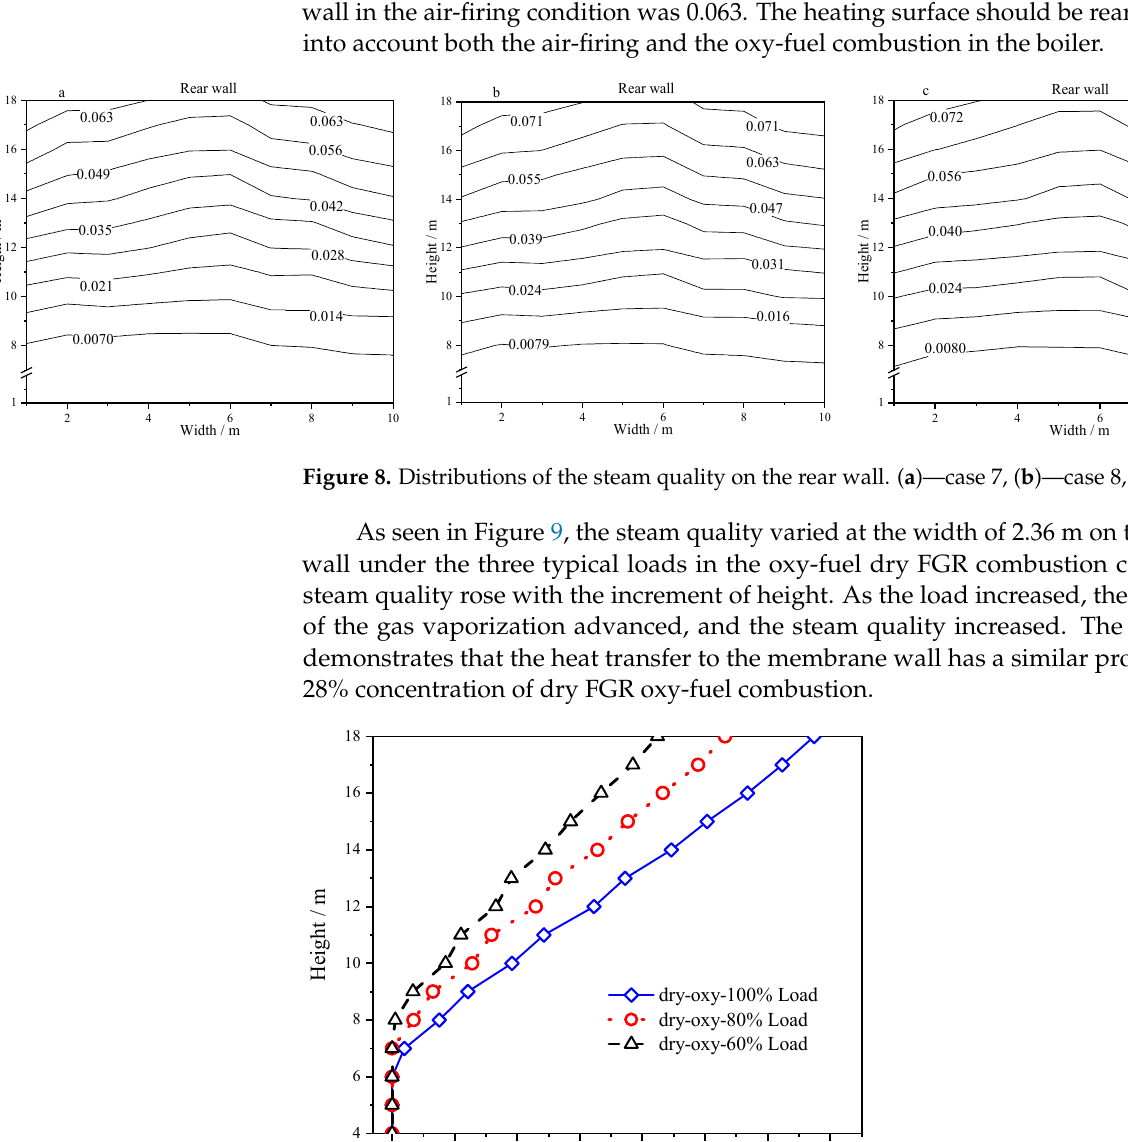
Figure 9. Steam quality on the front water wall under the dry FGR condition.